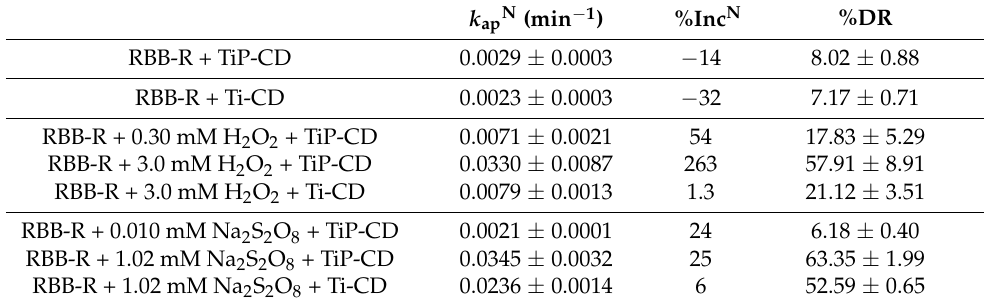
Figure 8. UV–Vis spectra of RBB-R as function of the ( a ) UV/H 2 O 2 /TiP-CD and ( b ) UV/S 2 O 82 − /TiP-CD exposition (pH = 7, and reaction time = 30 min). Table 5. Apparent rate constant, percentage of the rate constant when Ti-CD is present, and percentage of dye removal (at 30 min) of the UV + Ti-CD AOP of RBB-R (the standard deviations of at least three independent repetitions are shown). The fitting of the integrated first-order kinetics resulted in R 2 > 0.98.